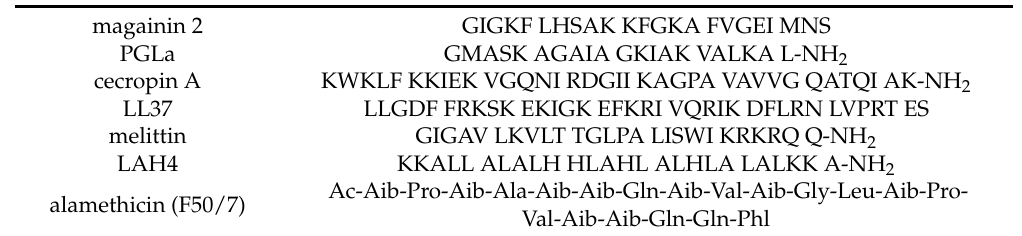
Table 1. Sequences of peptides discussed in this paper. The one-letter code is used for peptides made from conventional amino acids only. The alamethicin sequence is given by the three-letter code with the following non-standard residues: Aib: α -aminoisobutyric acid, Phl: L-phenylalaninol, Ac- for acetyl- and -NH 2 for the carboxamide terminus,